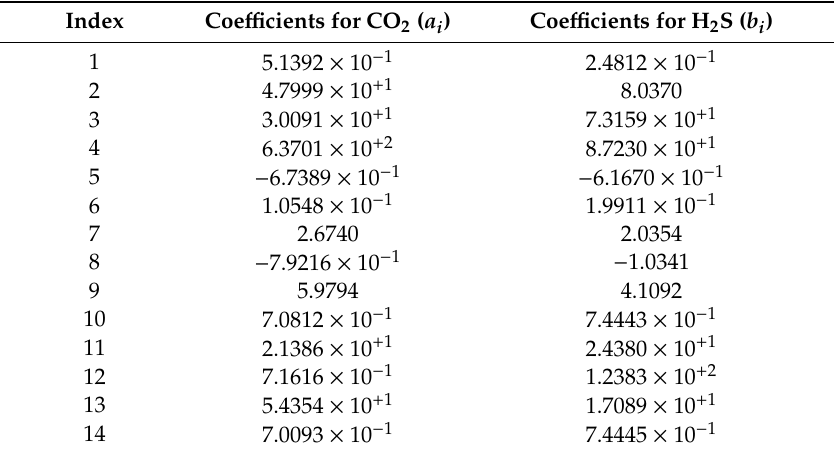
Table 3. Calculated coe ffi cients of the proposed model.